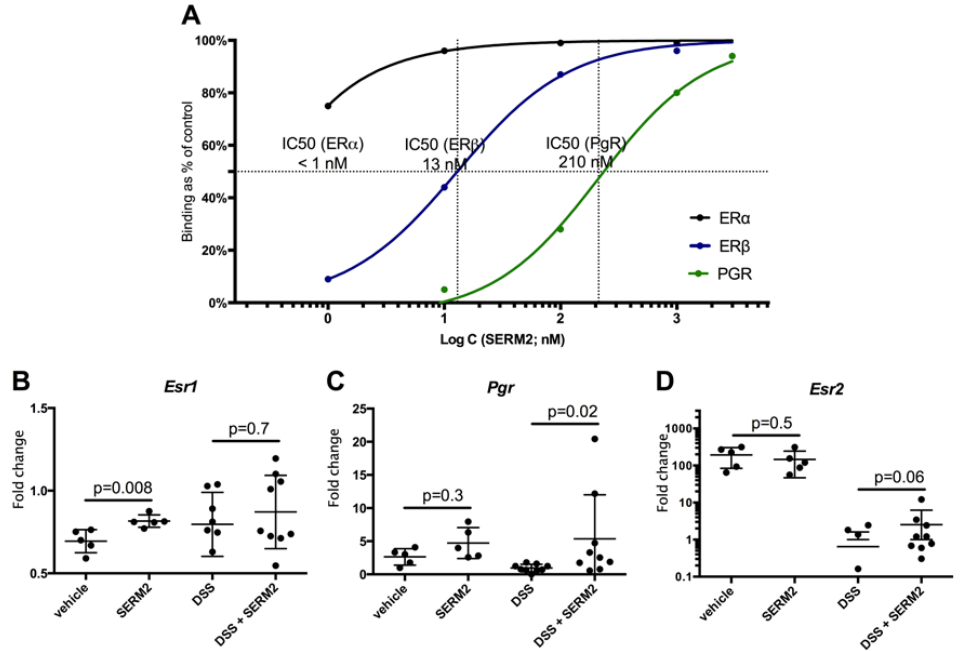
Figure 5. SERM2 binds with ER α , ER β , and PGR (subtype B). For binding in vitro ( A ) with human recombinant ER α and ER β , SERM2 competes 0.50 nM [ 3 H] Estradiol, and with PGR 0.50 nM [ 3 H] Progesterone, respectively. Data are presented as a relative binding: percent of saturation of the radioligand binding capacity versus SERM2 concentration. Binding a ffi nity curves and respective IC50 values were determined by a non-linear four-parameter logistic regression analysis. SERM2 modulated mean gene expression of nuclear receptors ( B ) Esr1, ( C ) Pgr, and ( D ) Esr2 in distal colon tissue, presented as a fold change to DSS vehicle group average. The data are expressed as the relative mean with SD, and one dot represents one mouse. Bact was used as a house-keeping gene. p -values representing statistical significances for SERM-treatment were calculated using unparametric Mann–Whitney test vs. respective